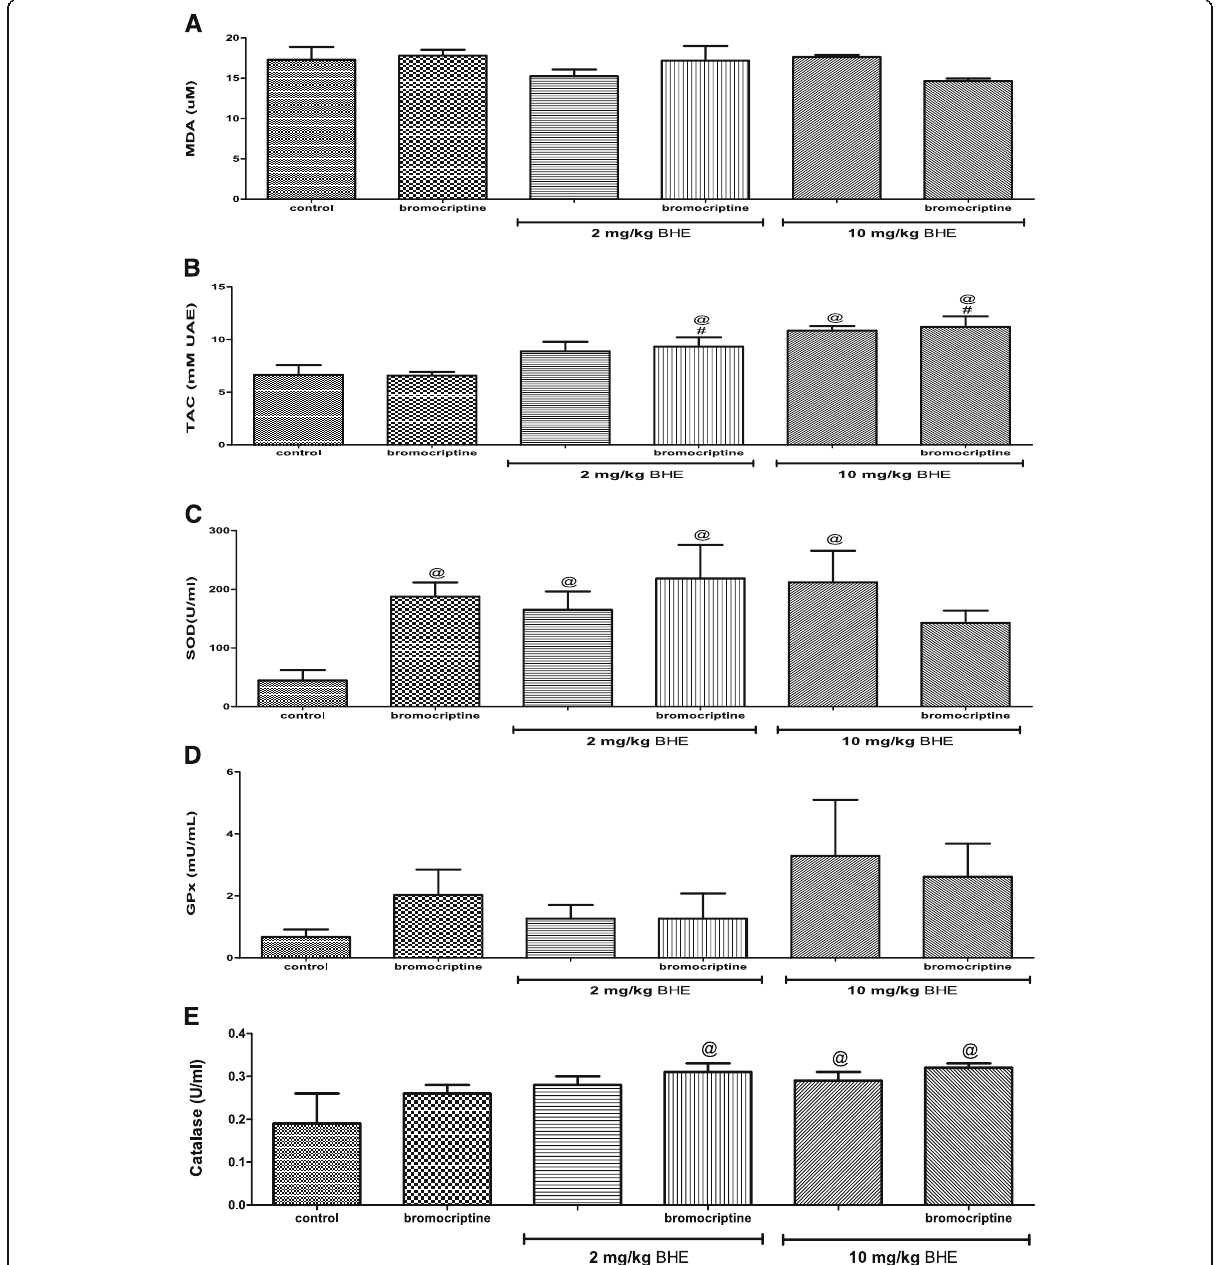
Fig. 2 Effects of bromocriptine and/or BHE on lipid peroxidation ( a malondialdehyde) and anti-oxidant status ( b total anti-oxidant capacity [TAC], c superoxide dismutase [SOD], d glutathione peroxidase [GPx], and e catalase) in male rats. BHE denotes Benin republic hemp ethanol